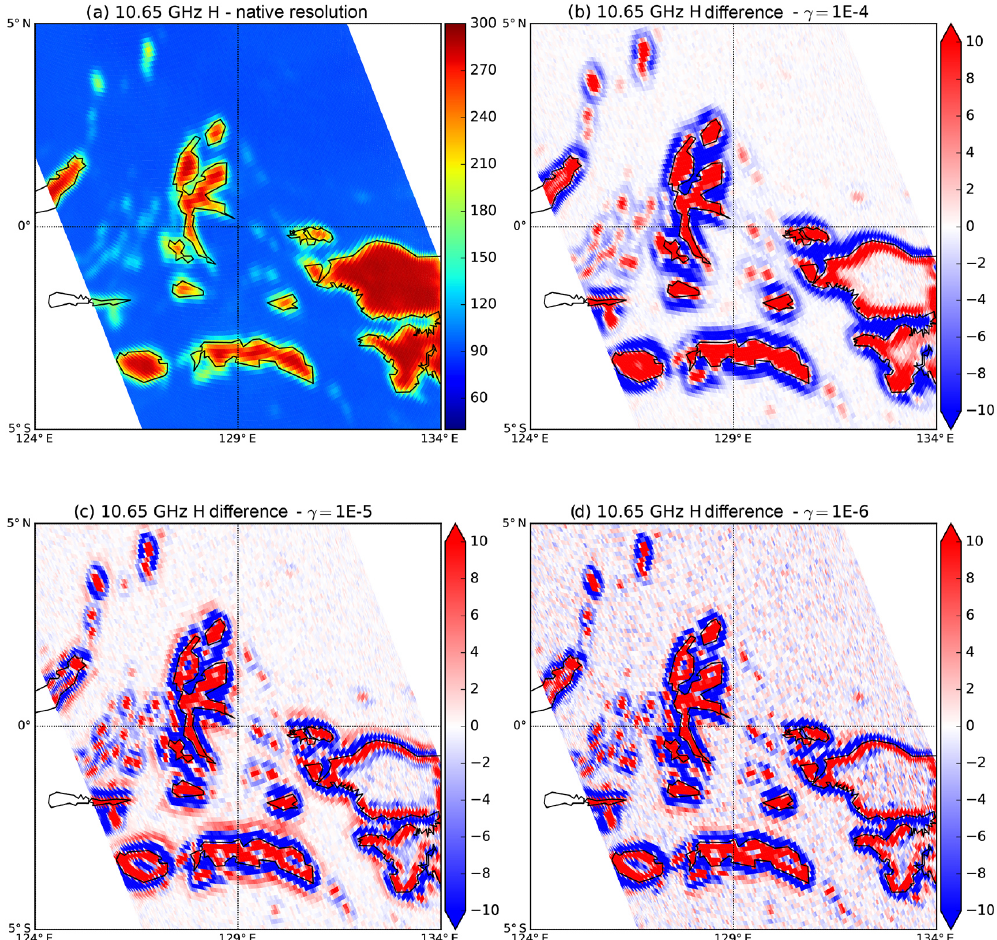
Figure 6. The effect of variations of the tuning parameter γ on the deconvolution of the 10.65GHz channels (brightness temperatures in K) as applied to real data. (a) Native resolution brightness temperatures [K]. (b) Differences between native and adjusted resolution for γ = 1 . 0 × 10 − 4 . (c) and (d) same as (b) but γ = 1 . 0 × 10 − 5 and γ = 1 . 0 × 10 − 6 ,